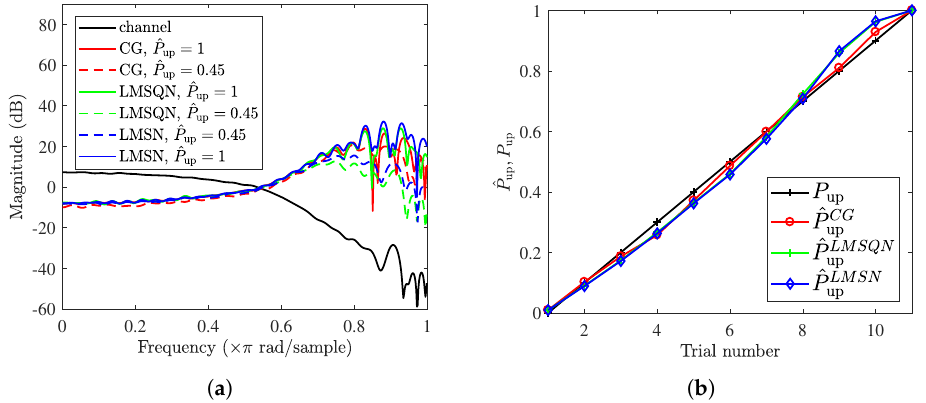
Figure 2. Simulation 1: ( a ) Frequency response of the channel and the data-selective filters ( b ) Comparison between the desired P up and achieved ˆ P LMSN up , ˆ P LMSQN up and ˆ P CG up by the data-selection algorithms.